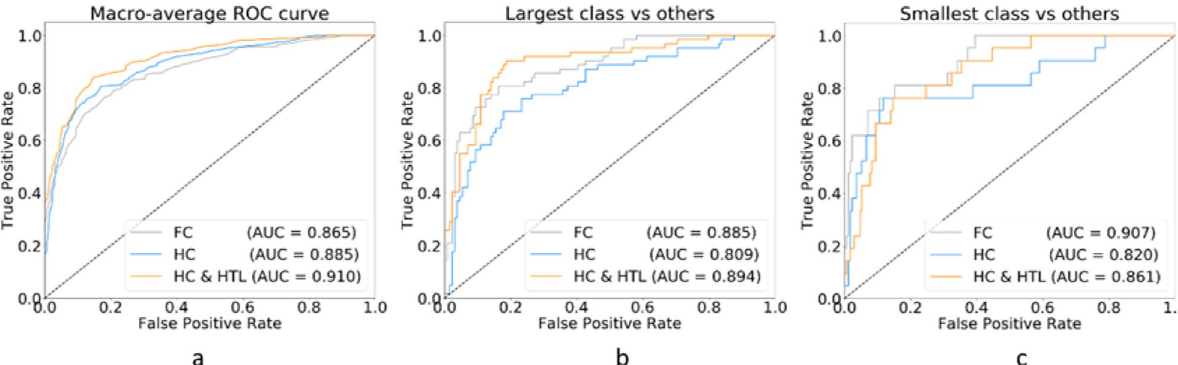
Figure 5. ROC curves for models built using a small training dataset. ROC curves for the stacked hierarchical classification model using hierarchy transfer learning: (a) macro-average ROC curve of all five classes, (b) ROC curves for the classification of the largest data class (MY) versus others, and (c) ROC curves for the classification of the smallest data class (SS) versus